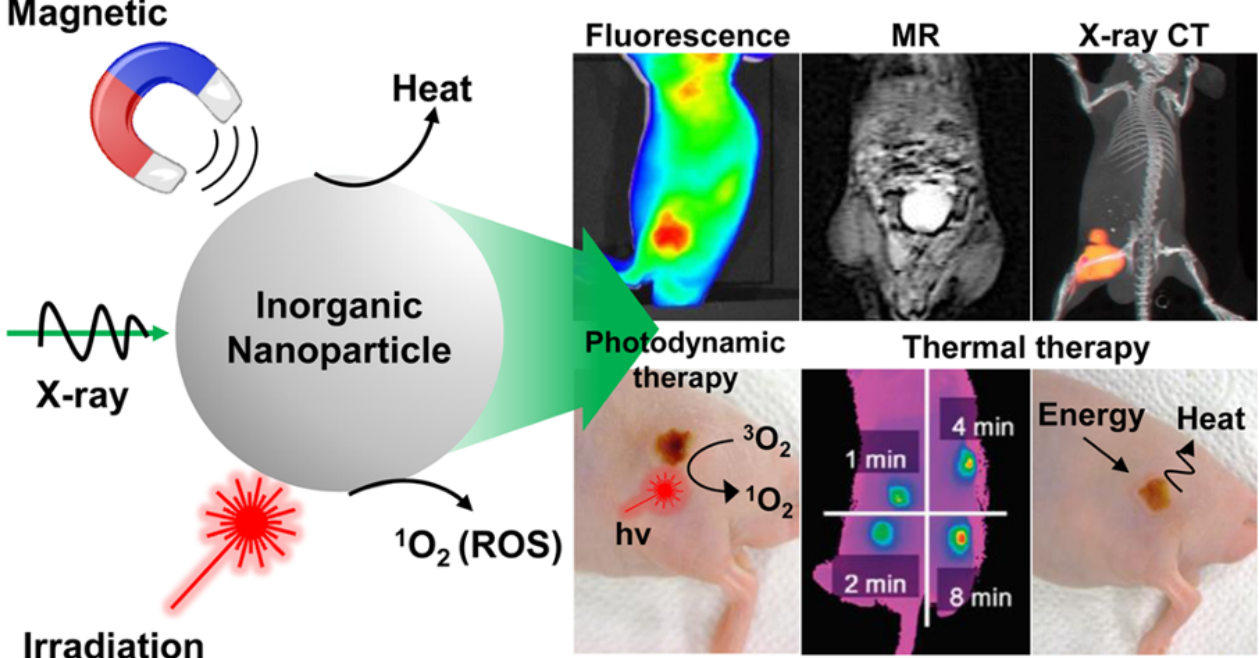
Figure 3. Applications of inorganic NPs for cancer therapy and imaging. Reproduced with permission from [40]. Copyright 2017 ACS Publications.